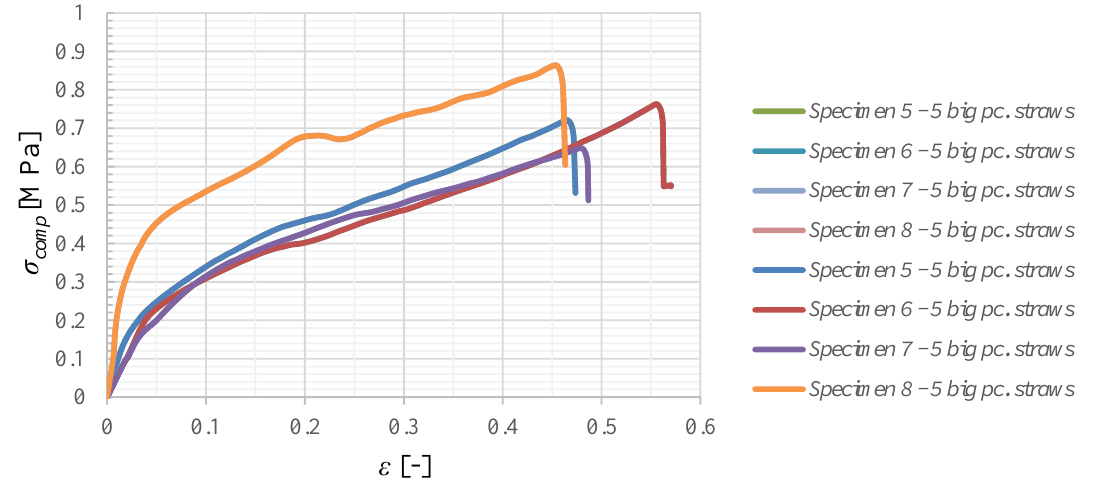
Figure 10. Measured results for polystyrene reinforced with large straws.